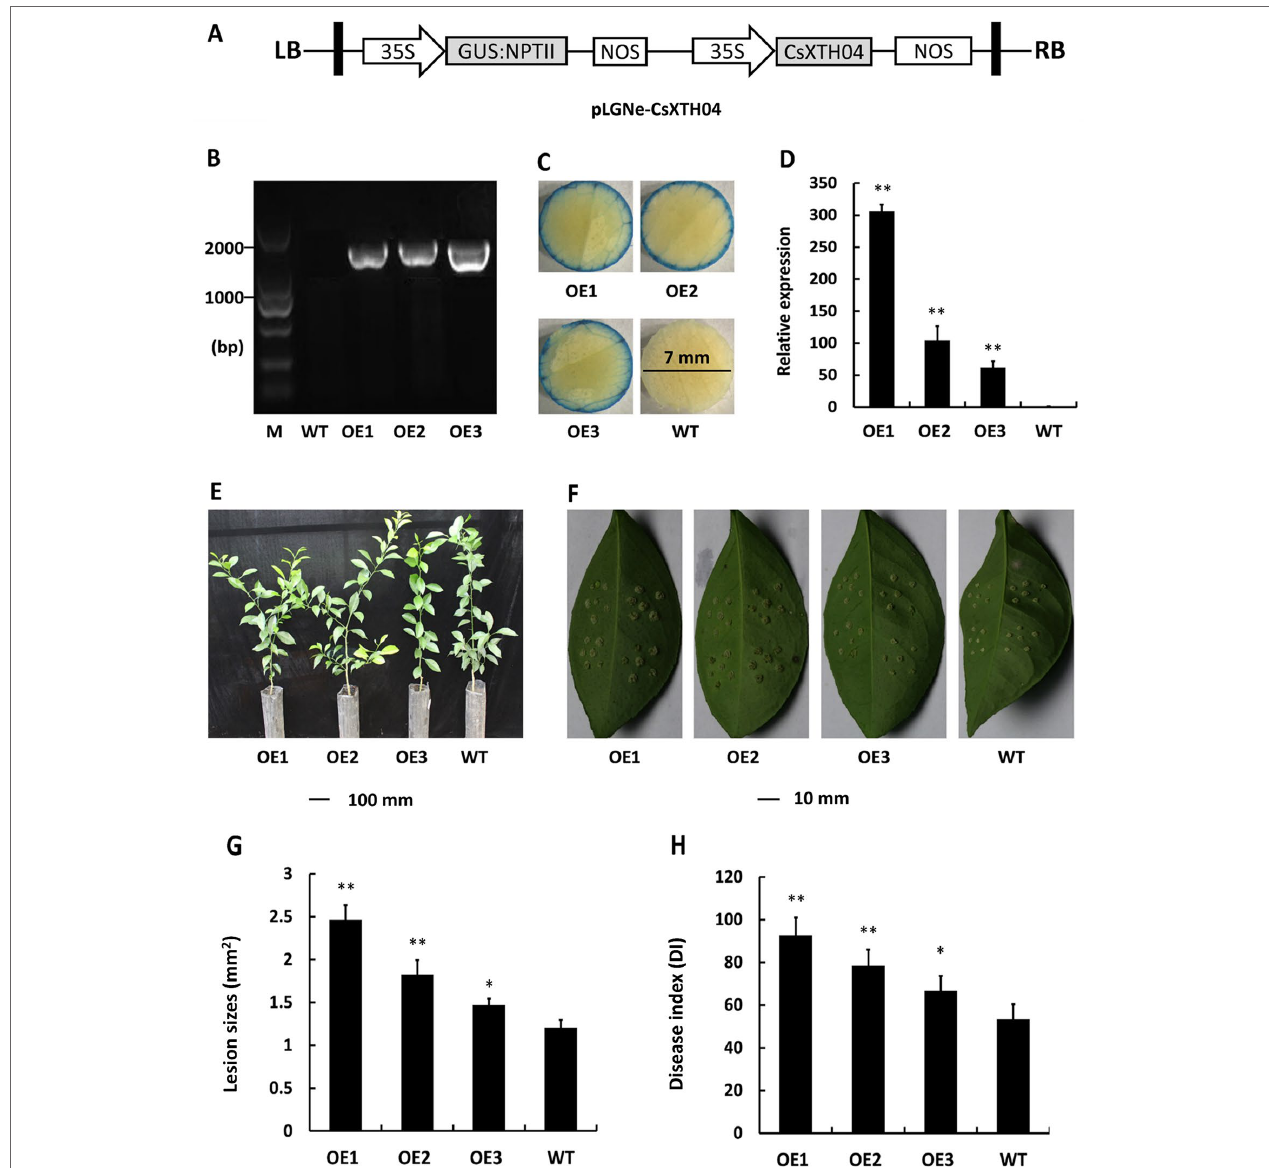
FIGURE 5 | Characterization and evaluation of CsXTH04 overexpression plants in response to Xcc. (A) Structure of the plasmids for overexpression assays (pLGNe- CsXTH04). LB, left border; RB, right border; 35S, CaMV35S promoter; NOS: terminator. (B) Validation of transgenic plants by PCR. (C) Validation of transgenic plants by GUS assays (leaf disc diameter = 7 mm, staining period = 24 h). (D) Overexpression of CsXTH04 detected by qRT–PCR. (E) Phenotypes of transgenic plants. (F) Disease symptoms on leaves of overexpressed transgenic and WT plants inoculated by Xcc. Sampling and imaging at 10 dpi. Lesion sizes (LSs) (G) and disease index (DI) (H) of each transgenic plant were assessed to evaluate disease resistance. In (D) , (G) , and (H) , * P < 0.05, ** P < 0.01 Student’s t -test. Each value represents the mean ± SD. In (B) to (H) , OE1–OE3 indicate overexpression plants; WT, wild type. In (B) , M indicates DNA marker. qRT–PCR, quantitative reverse transcriptase–polymerase chain reaction; Xcc, Xanthomonas citri subsp. citri